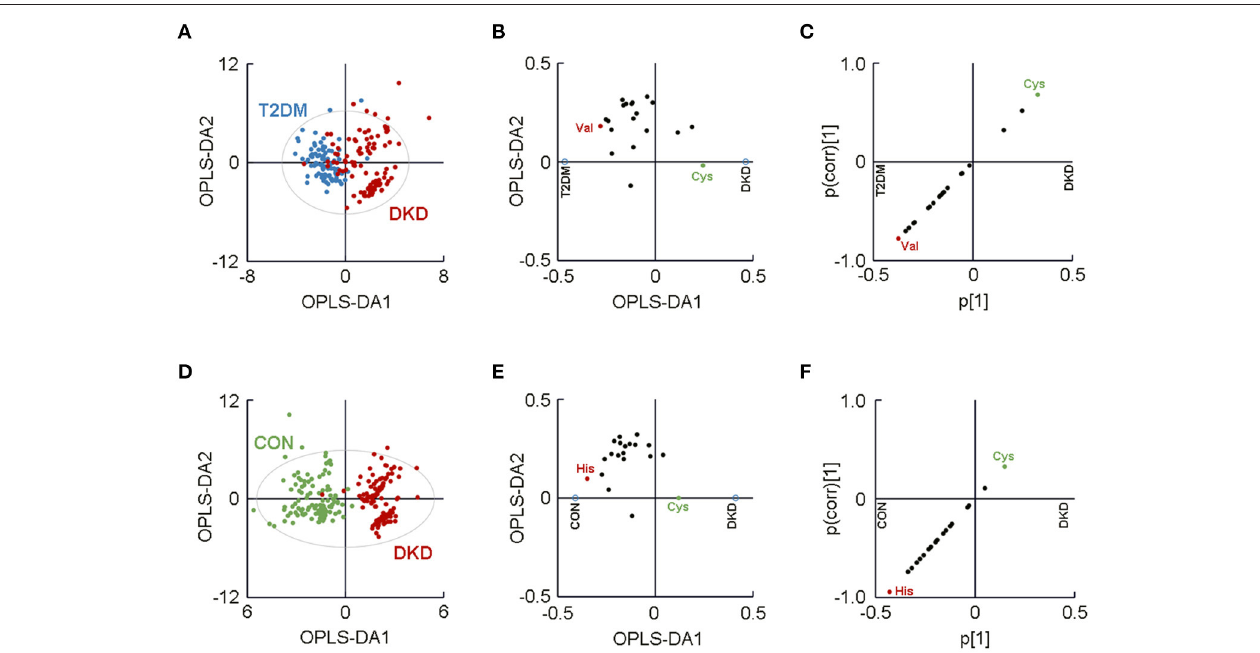
FIGURE 2 | Separated metabolomic analyses highlighted visual separation of the DKD group from the T2DM group and the CON group. (A) Orthogonal partial-least-squares discriminant analysis (OPLS-DA) plot showing the visual separation between the DKD group and the T2DM group. The (B) loading plot and (C) SUS plot identified plasma levels of valine and cysteine to be the major contributors to the separation between the DKD group and the T2DM group. (D) OPLS-DA plot showing the visual separation between the patients with DKD and CON group. The (E) loading plot and (F) SUS plot identified plasma levels of histidine and cysteine as the major amino acids contributing to the difference between the DKD group and the CON group. The ellipse indicates the Hotelling T2 (0.95) range for the model. DKD, diabetic kidney disease; T2DM, type 2 diabetes mellitus; CON, healthy